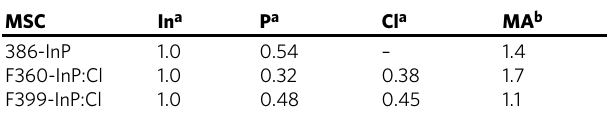
Table 1 Chemical compositions (atomic%) of 386-InP MSCs, F360-InP:Cl MSCs, and F399-InP:Cl